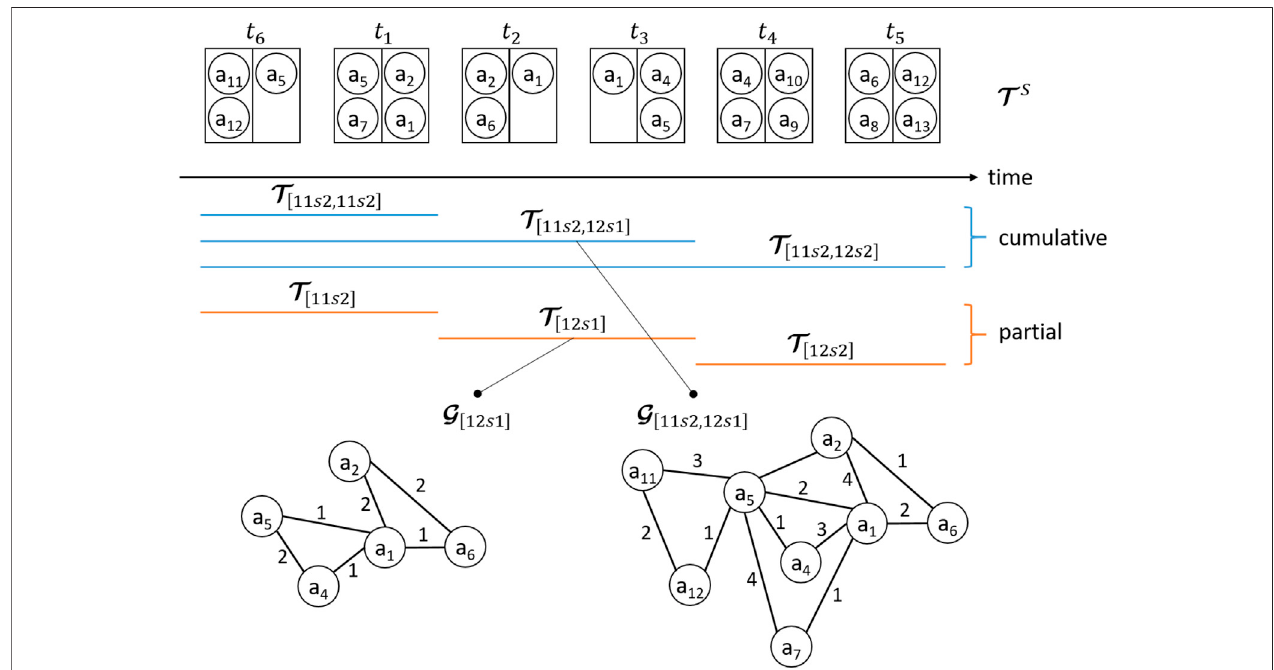
FIGURE 2 | Cumulative and partial transaction sets, and construction of the Address Correspondence